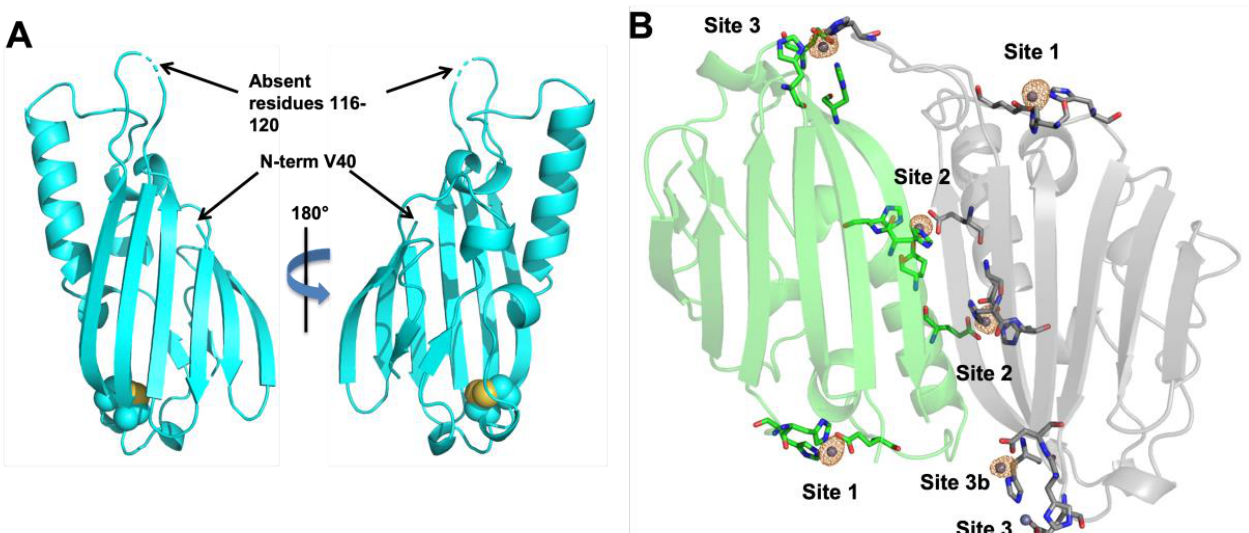
Figure 4. Crystal structures of ∆ 124-184 ZrgA. ( A ) Apo protein with backbone shown in cartoon format and Cys residues comprising the disulfide bond shown as spheres. ( B ) Protein bound to zinc. Chains A (green) and D (gray) are shown. Backbone atoms are shown as cartoon, zinc ligands are shown as sticks colored according to element and zinc ions are shown as spheres. The anomalous difference density map (orange mesh) is contoured to 5 σ showing the positions of zinc ions. Figure created with Pymol version 2.5.4, Schrödinger, LLC. New York, NY, USA.